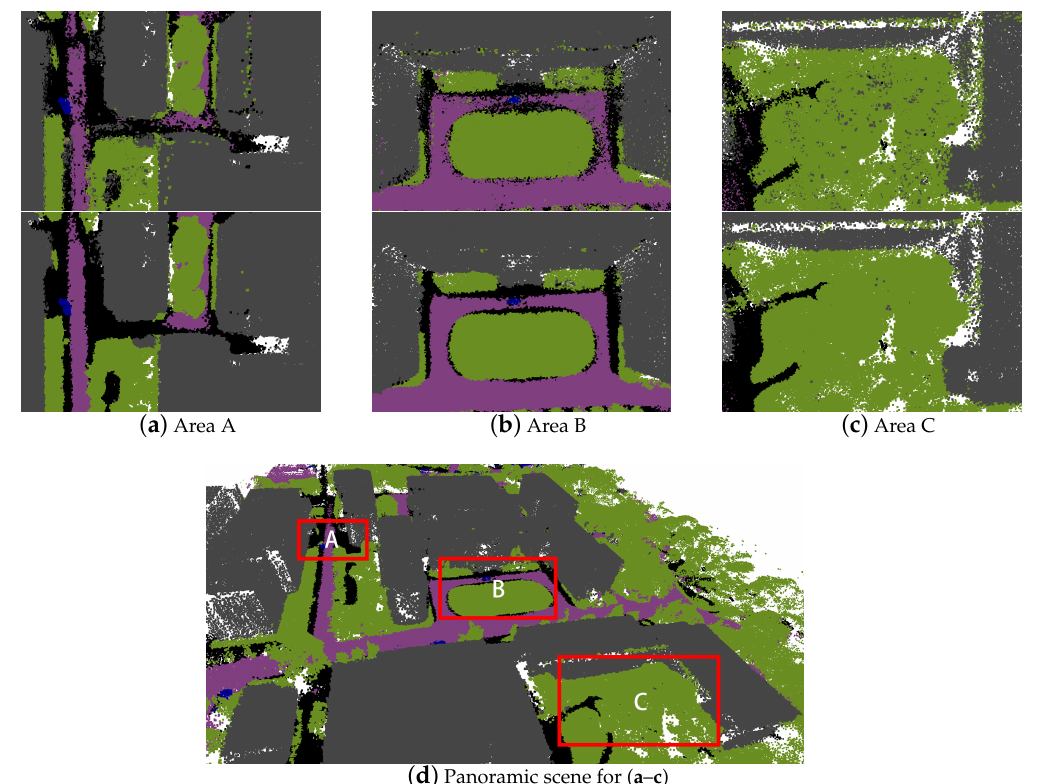
Figure 4. Comparison between the point clouds before and after refinement. ( a – c ) Top: coarse result. Bottom: refined result. ( d ): The panoramic scene for ( a – c